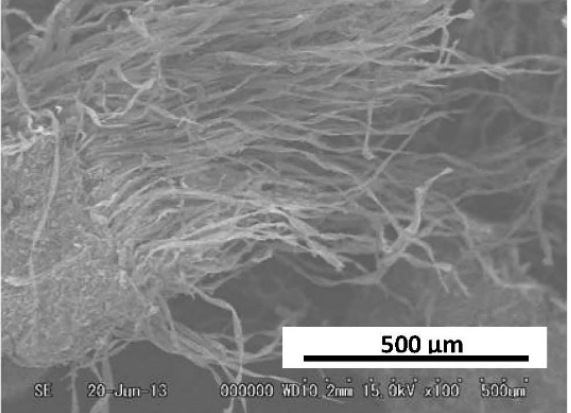
Figure 5. Scanning electron micrographs of skin of ‘Porotan’ (×500). Acceleration voltage: 20 kV.